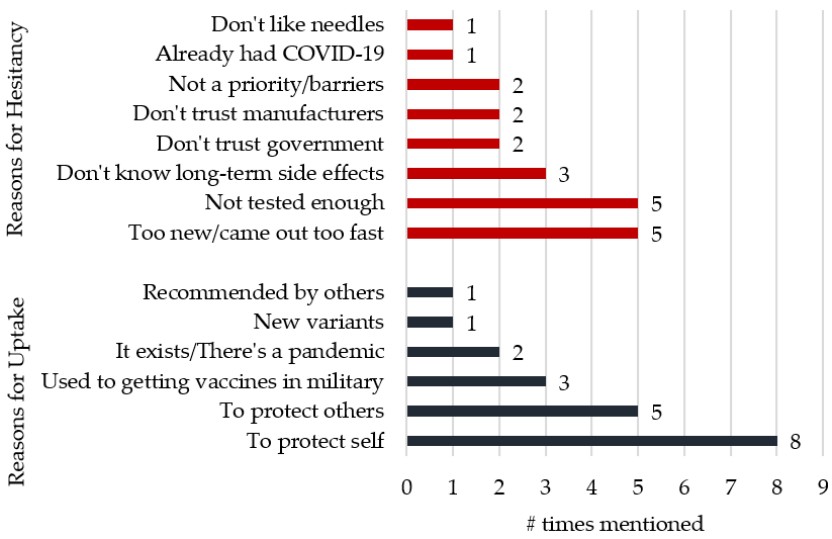
Figure 2. Reasons Given for COVID-19 Vaccine Willingness or Hesitancy.